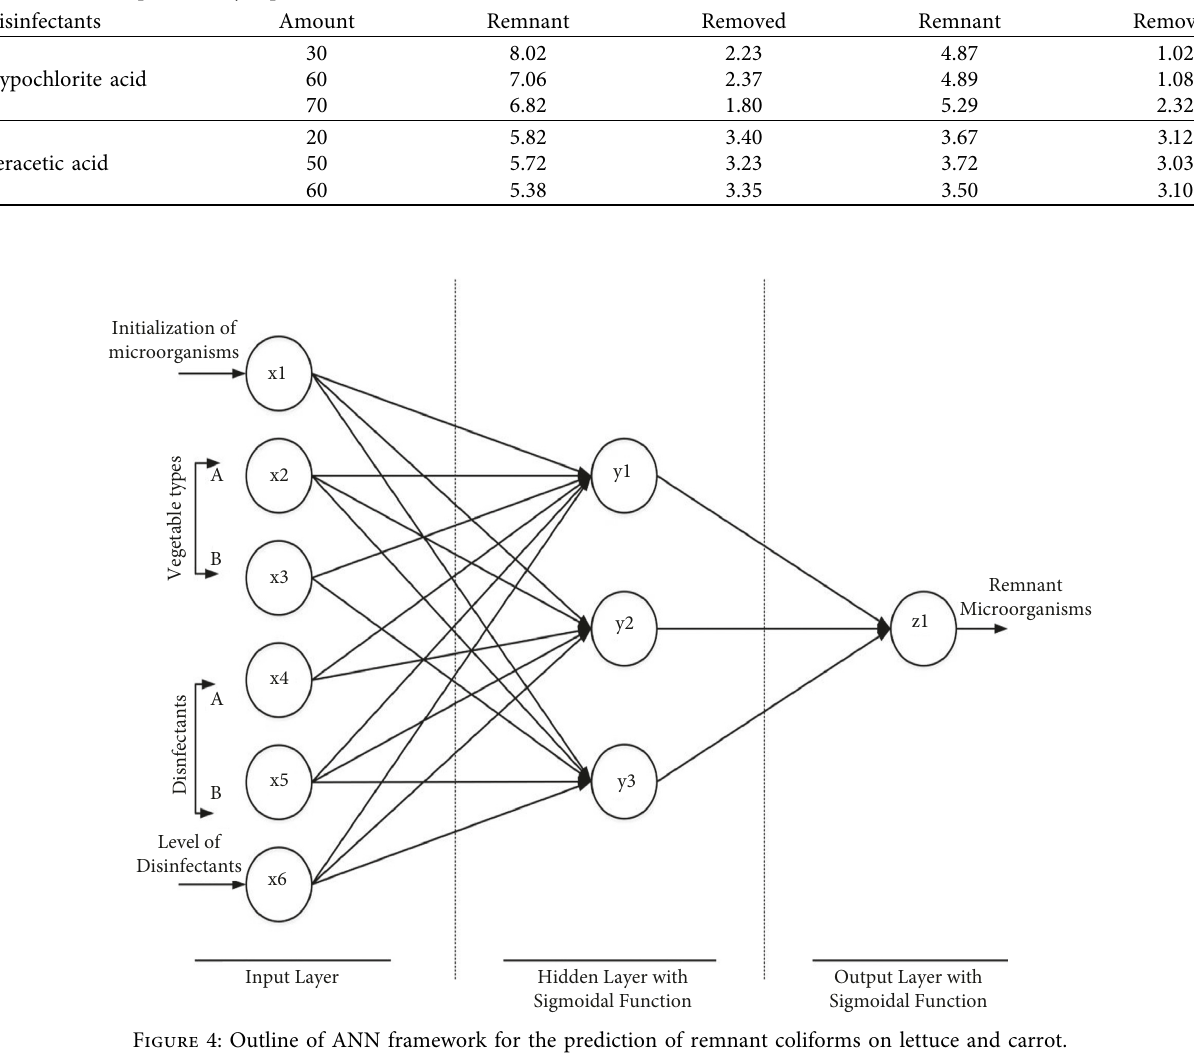
Figure 4: Outline of ANN framework for the prediction of remnant coliforms on lettuce and